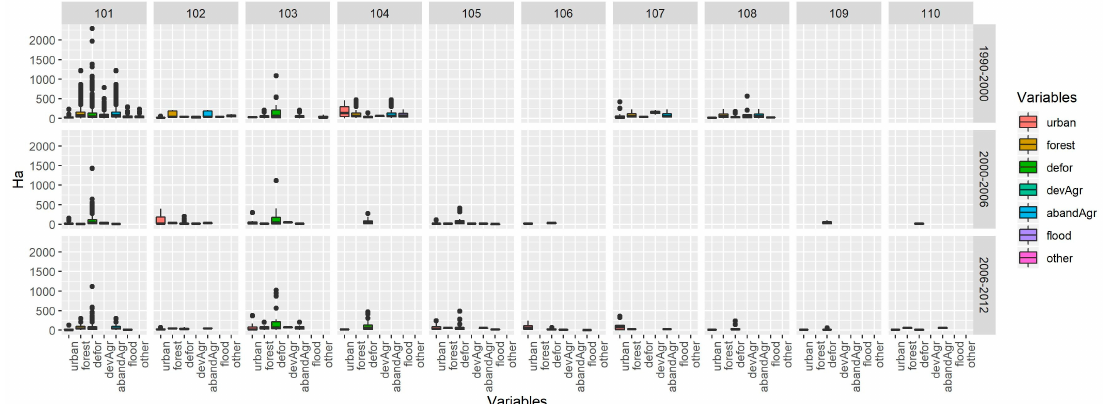
Figure4. Landusechangesbygridcells. Thevariationoftransitionaldynamicsisshowedbyregionsand Figure 4. Land use changes by grid cells. The variation of transitional dynamics is showed by regions study period. Transitional dynamics: urban—Urbanization; forest—Forestation; defor—Deforestation; and devAgr—Agriculture development; abandAg—abandonment of agricultural; flood—flooded areas; other—other land use changes. Regions as shown in Figure